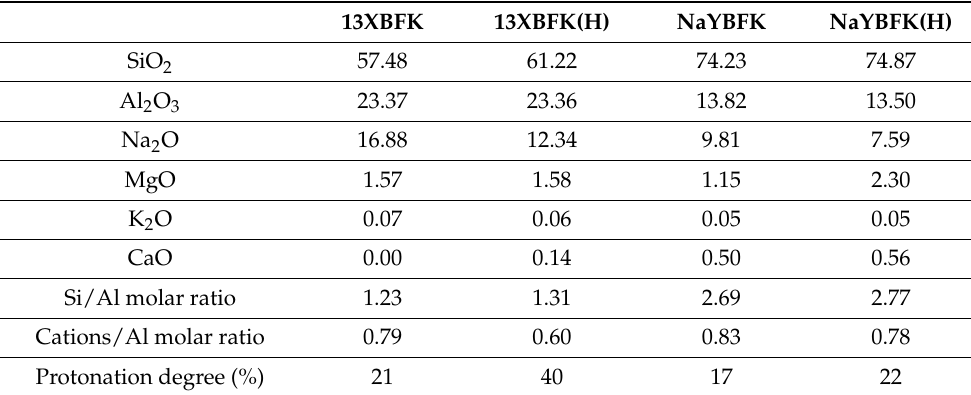
Table 1. Chemical composition in molar fraction (mol